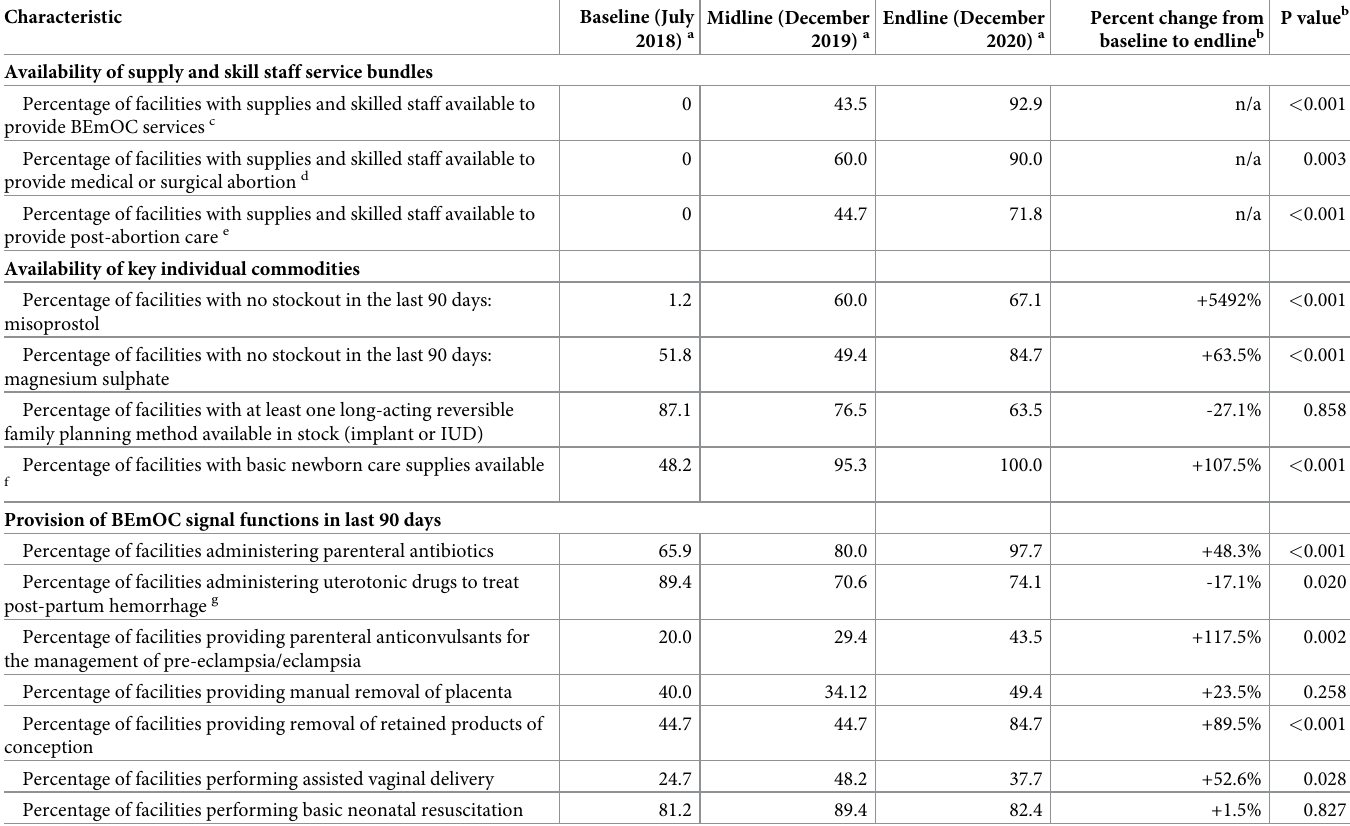
Table 5. Facility characteristics at baseline, midline, and